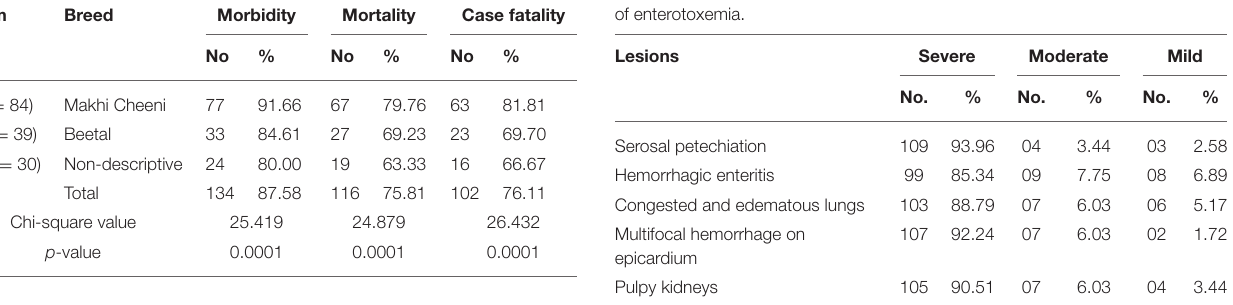
TABLE 4 | Intensity and frequency of necropsy lesions in goats ( n = 116) that died of